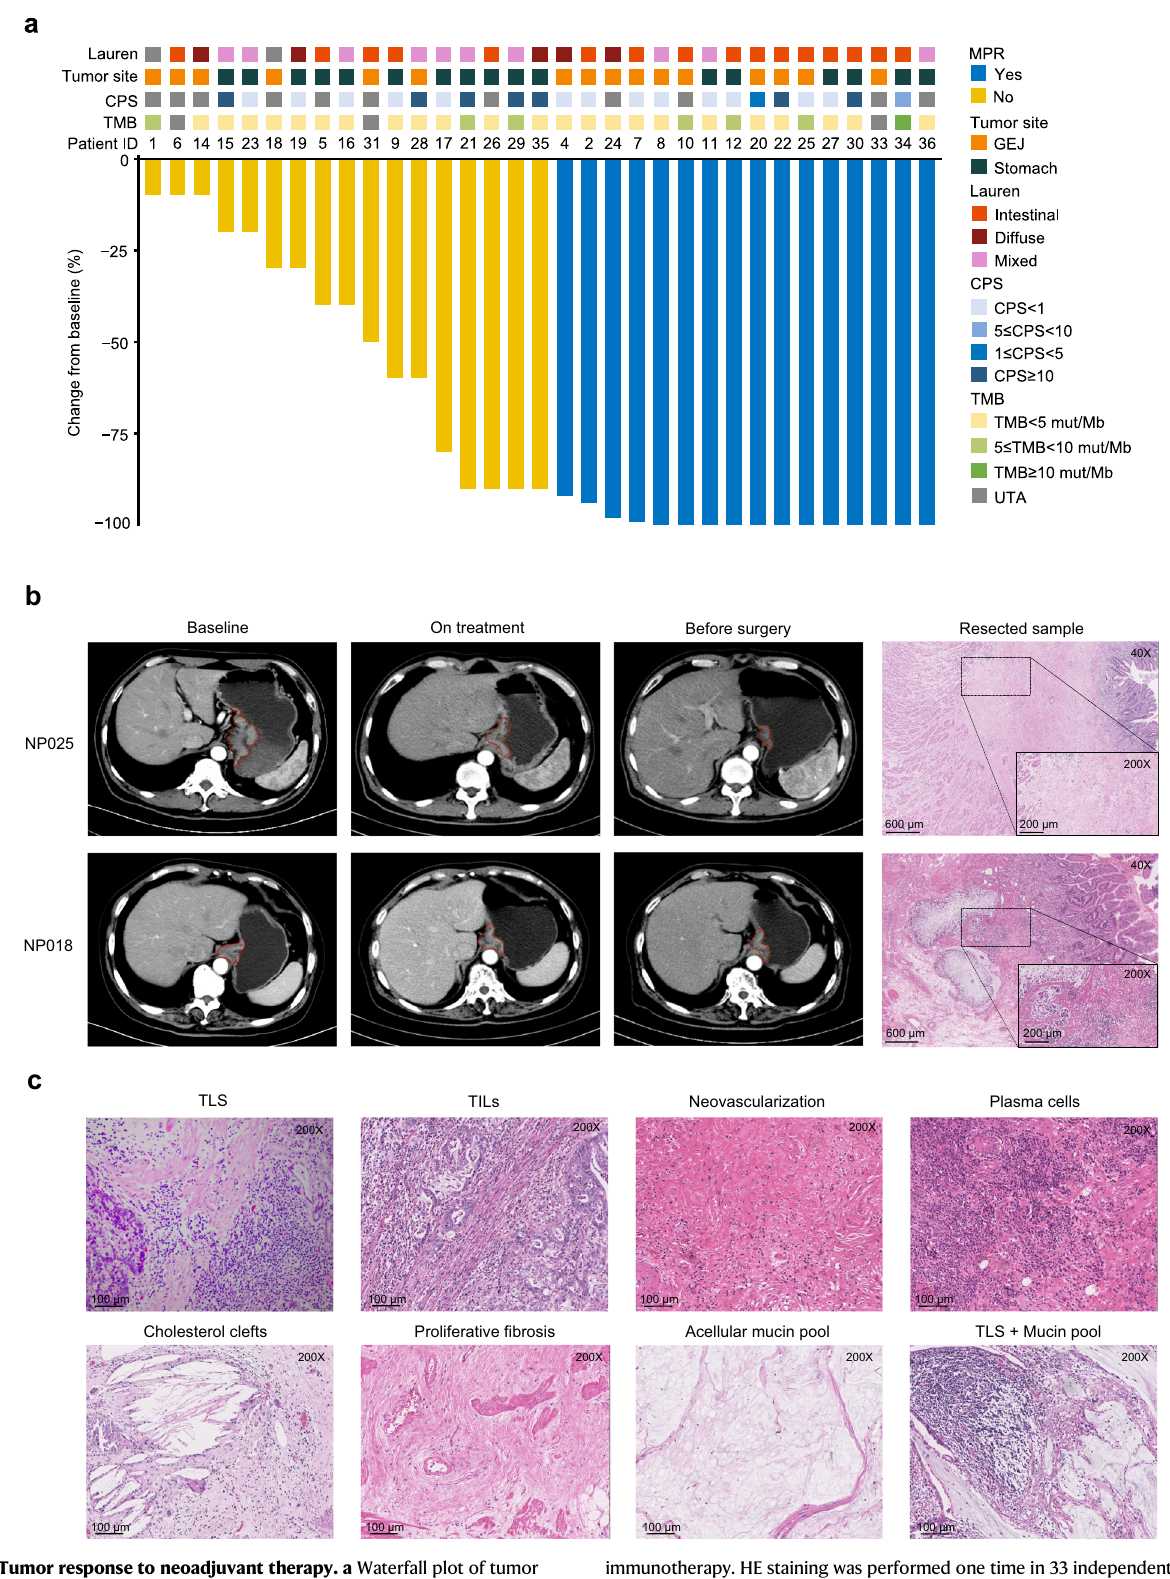
immunotherapy. HE staining was performed one time in 33 independent samples with similar results. CPS combined positive score, UTA unable to access, GEJ gas- troesophageal junction, MPR major pathologic response, HE hematoxylin and eosin, TLS tertiary lymphoid structures, TILs tumor-in fi ltrating lymphocytes. Source data are provided as a Source Data fi